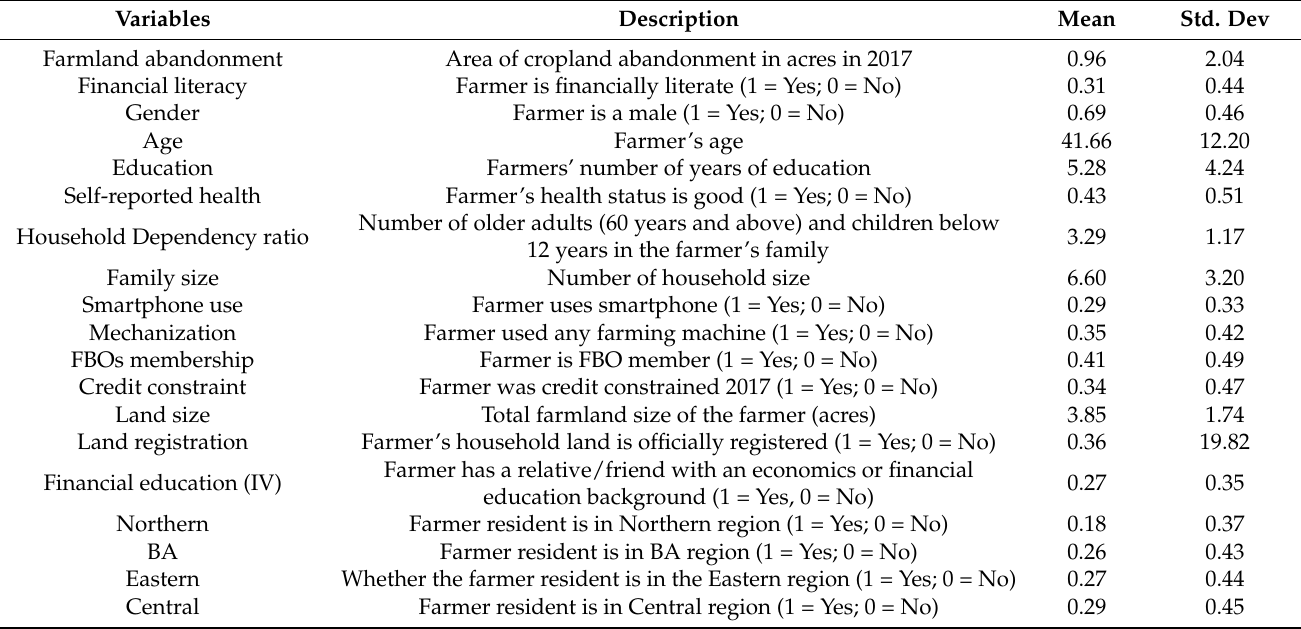
Table 1. Demographic and socioeconomic characteristics of